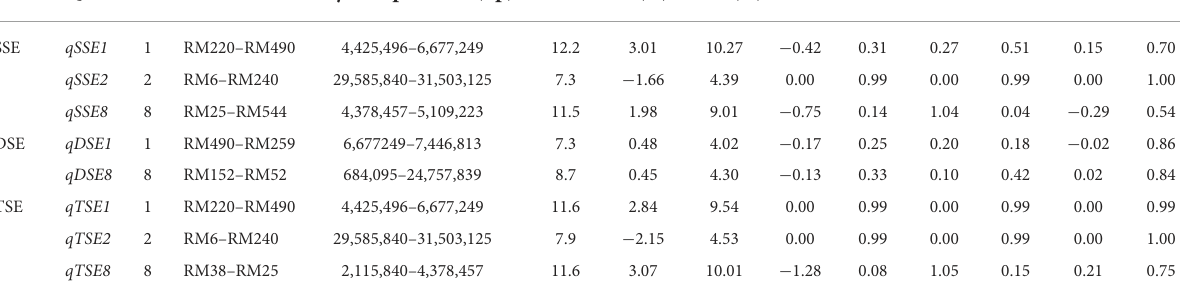
TABLE 3 Putative stigma exsertion rate QTLs detected by linkage mapping in Collection 1. Traits QTL Chr. Interval